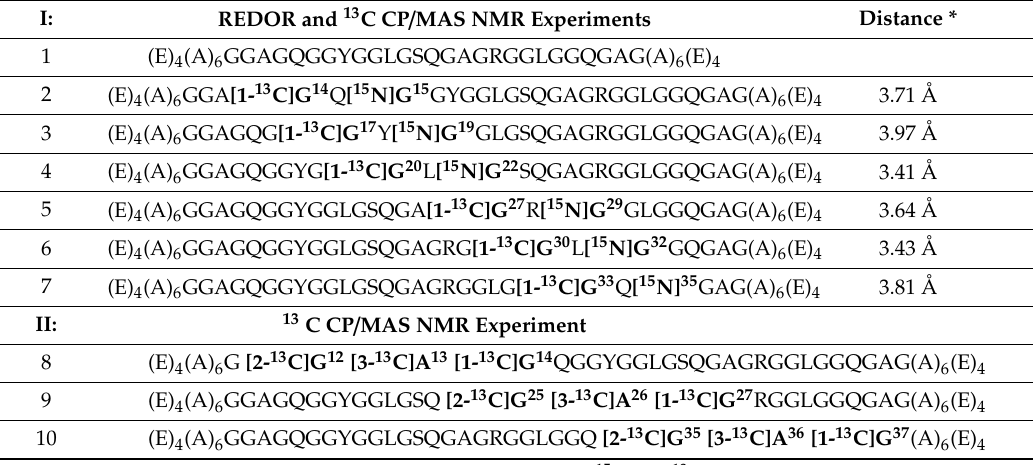
Distance * is the inter-nuclear distance between 15 N and 13 C labeled sites